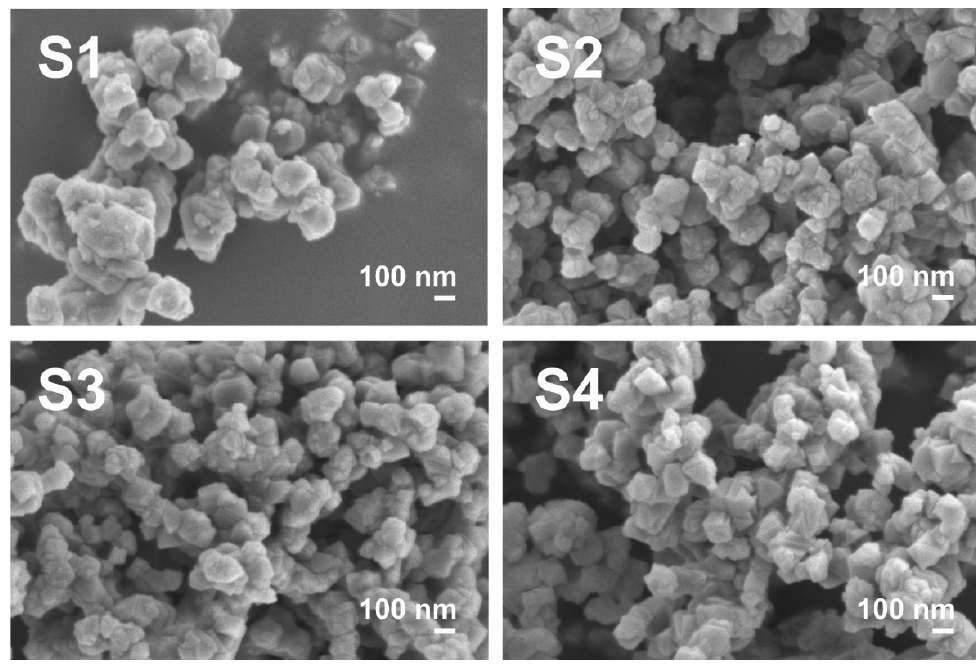
Figure 4. SEM images of pristine sol–gel LTO S1–S4.